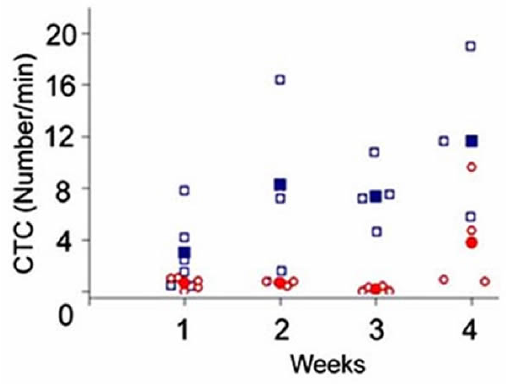
Figure 11. Average melanoma CTC rate in 150 µm-diameter skin vessels as a function of time after B16F10 cell inoculation in the ear ( red open circle ) and skin ( blue open square ); filled red circle and filled blue square, averaged data (905 nm, 30 mJ/cm 2